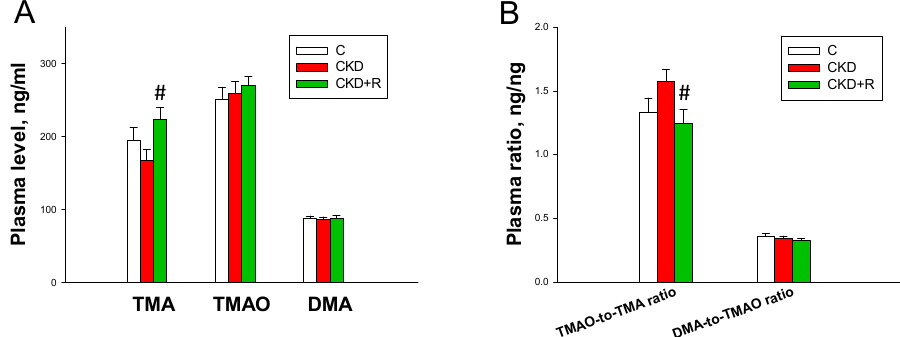
Figure 6. Effects of maternal CKD and R treatment on the trimethylamine (TMA)– trimethylamine- Figure 6. E ff ects of maternal CKD and R treatment on the trimethylamine (TMA)-trimethylamine- N N -oxide (TMAO) pathway in male offspring at 12 weeks of age. (A) Plasma levels of TMA, TMAO, and dimethylamine (DMA). (B) The TMAO-to-TMA and DMA-to-TMAO ratios in the plasma. N = 7– 8/group; # p < 0.05 vs. CKD.